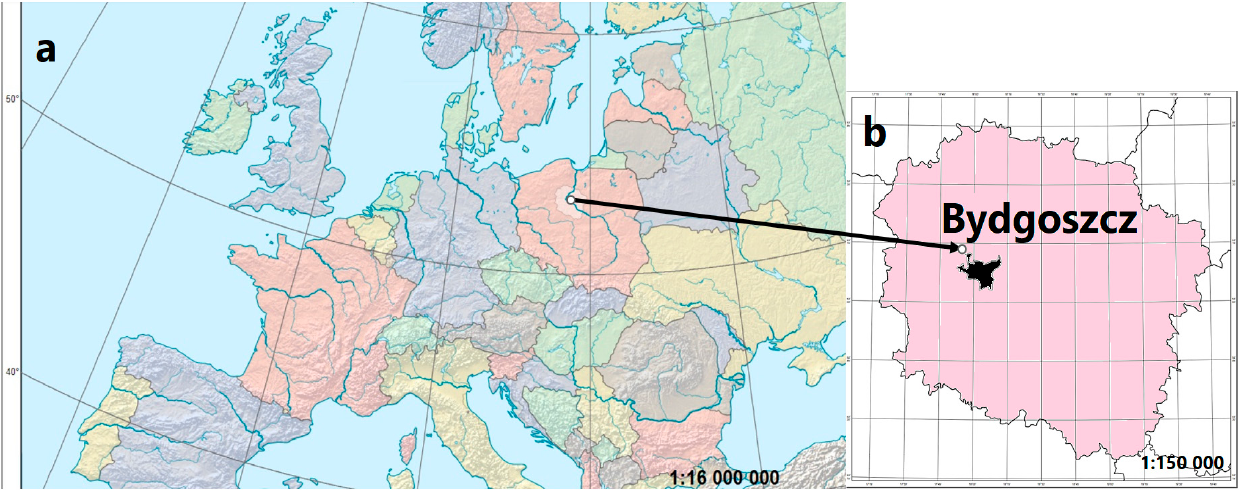
Figure 1. Location of the region of Kujawsko-Pomorskie in Europe ( a ) and the region of Bydgoszcz; ( b ) where the field experiment was carried out.